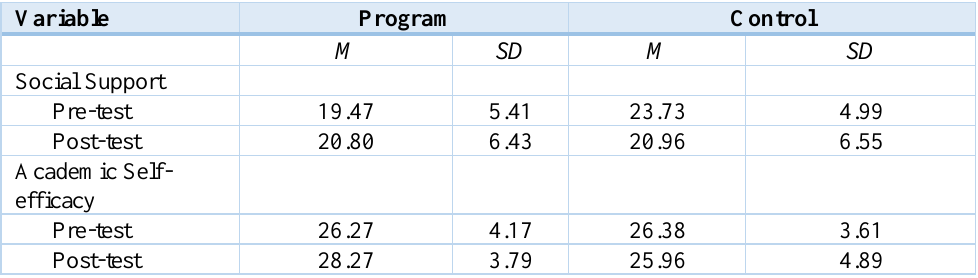
Descriptive Statistics for Social Support and Academic Self-Efficacy at Pre- and Post-Test